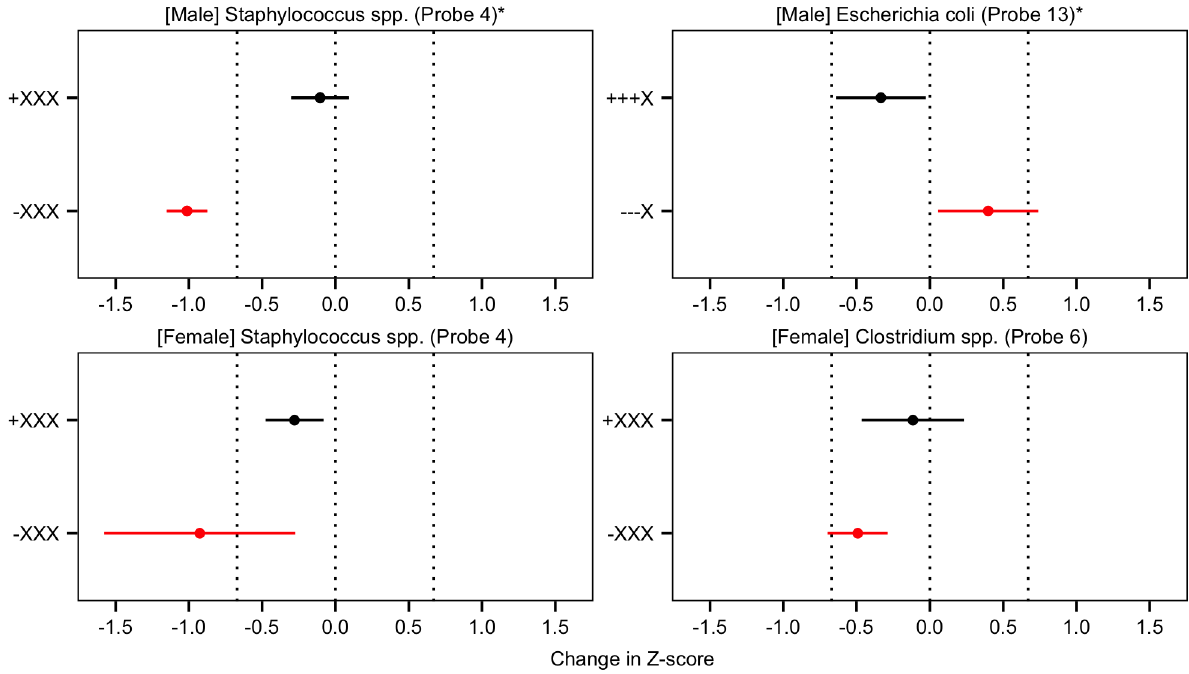
Figure 4. Results from the pattern analysis. The exposure pattern is represented by four characters, constructed from ‘‘ z ’’, ‘‘ { ’’, and ‘‘X’’, which represent detection, non-detection, and irrelevance, respectively, for the four time points of the analysis (days 4, 10, 30, and 120). The black points and lines represent estimated means and 95% confidence intervals for patterns that were found to be significantly close to zero at an false discovery rate of 5%. The crude contrasts (i.e. if ‘‘ z{ XX’’ was significant, the crude contrast would be ‘‘ {z XX’’) that were significantly different to zero at a ~ 5% have their estimated means and 95% confidence intervals displayed in red. For the testing of the difference of the means of the two patterns, significant results (at a ~ 5% ) is indicated by (cid:2) , otherwise significance is a ~ 10% . Vertical lines are displayed at { 0 : 67 and 0 : 67 , representing the boundaries of expected growth.